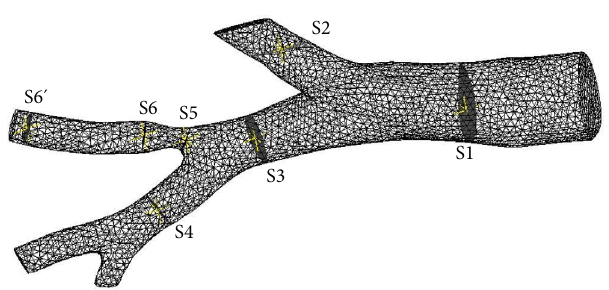
F IGURE 2: Sectional view of pulmonary artery